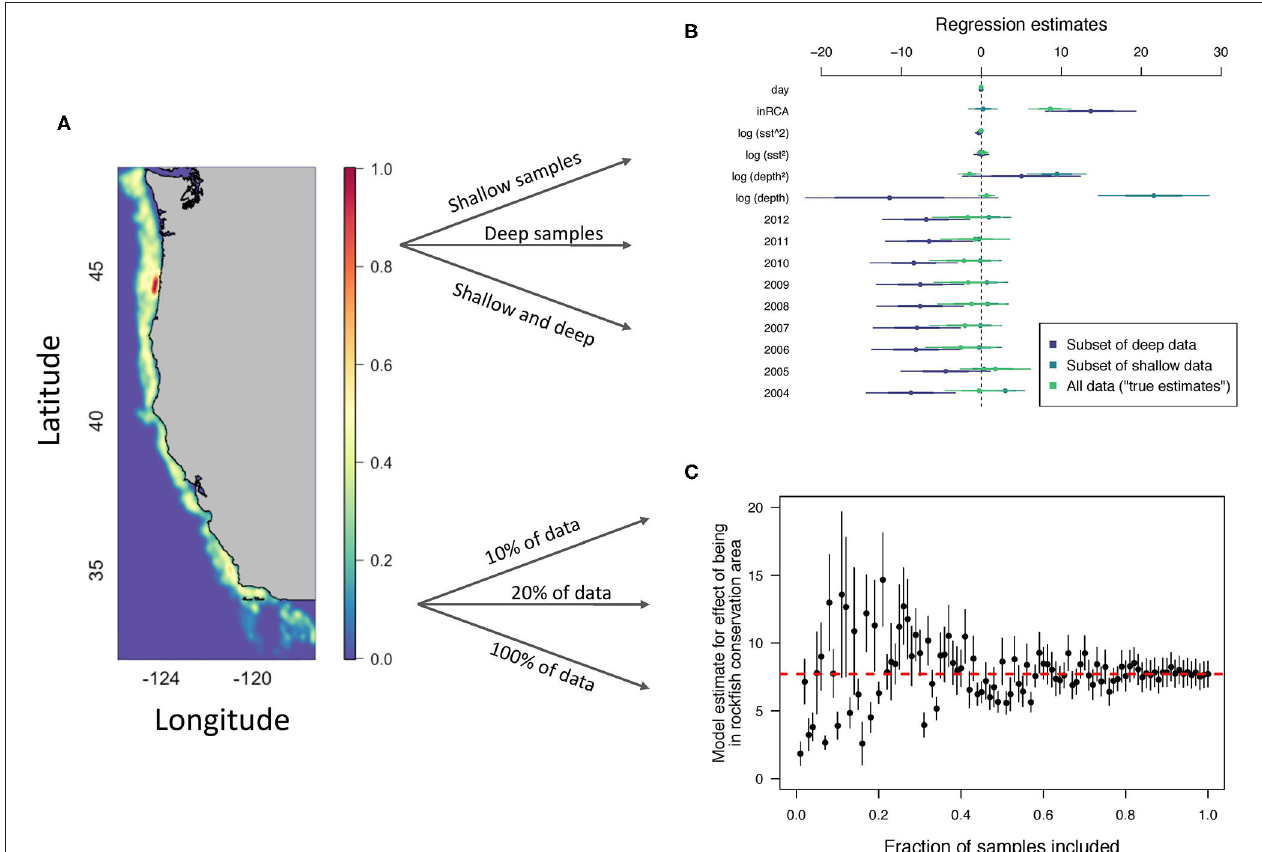
FIGURE 2 | Subsampling process for darkblotched rockfish ( Sebastes crameri ) catch in kg in U.S. West Coast Groundfish Bottom Trawl Survey data from 2003 to 2012. (A) Bivariate kernel density estimate showing smoothed density of fishing effort (7,161 haul locations) (Keller et al., 2017; Stock et al., 2019). (B) Parameter estimations for linear regression of three subsamples of data: deep trawls, shallow trawls, and all combined data (Note: the number of records was kept consistent for the three groups). (C) Estimate for the effect of being in a rockfish conservation area (inRCA) on catch for different amounts of data included. The horizontal, dashed line is the “true” estimate which is the estimate when 100% of the data is included.